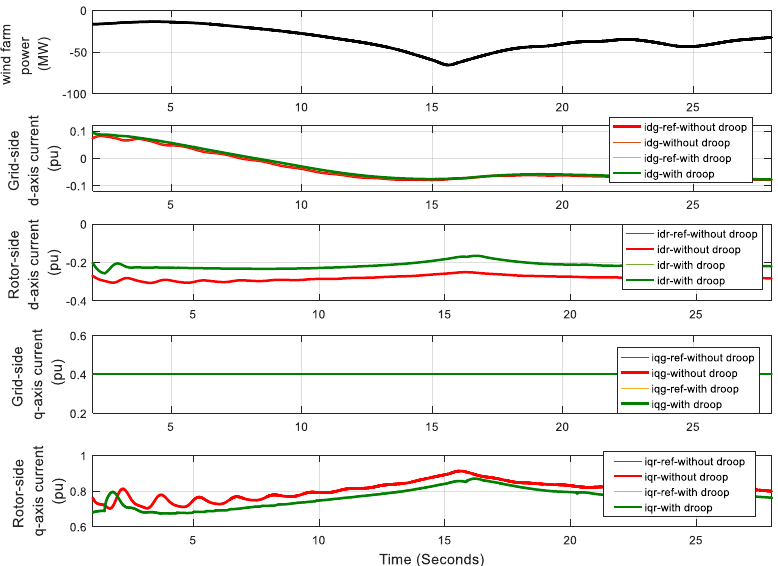
Figure 13. Tracking of inner loop control reference signals in the droop and without droop-fed vector control of the VSPS system along with wind farm.